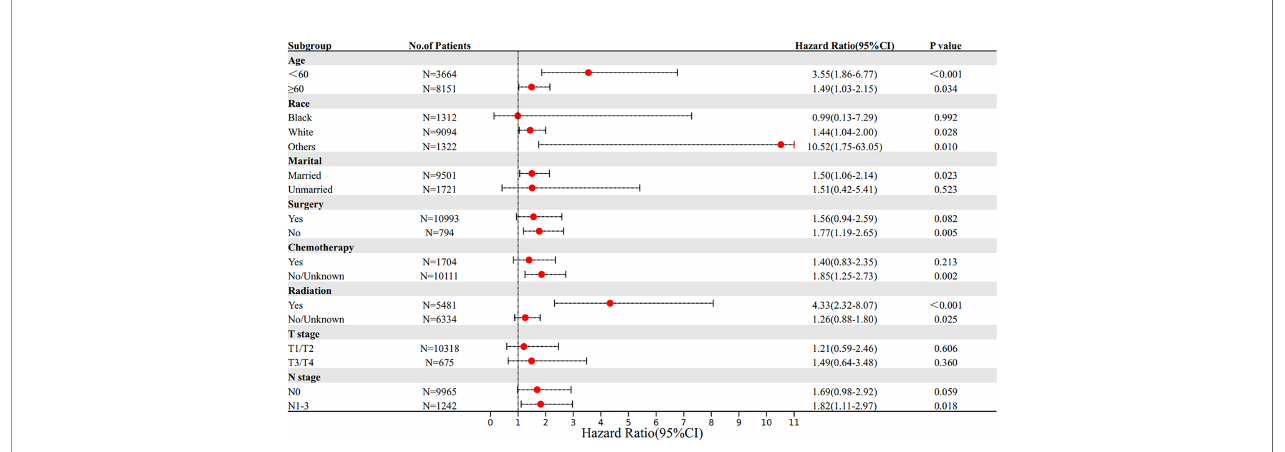
FIGURE 5 | Subgroup multivariate Cox proportional hazards model comparing BCSS between SRCC and MBC. BCSS, breast cancer-speci fi c survival; SRCC, primary breast signet ring cell carcinoma; MBC, mucinous breast